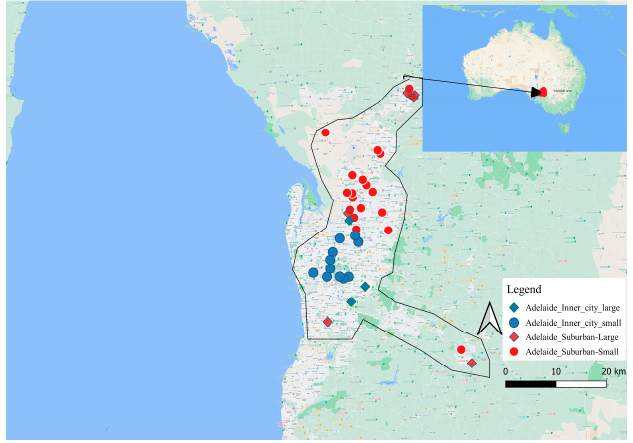
Figure 1. Map of the location of 40 assumed UA production sites in Adelaide, South Australia. Background image courtesy of Google Maps, image generated using